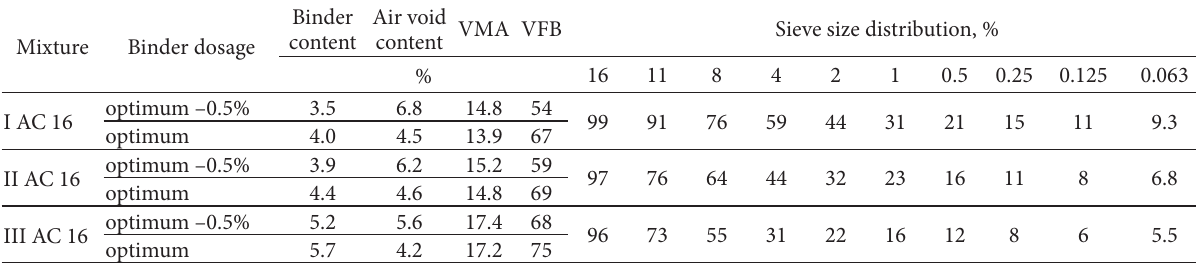
Table 2. AC 16 mixture design evaluation Mixture